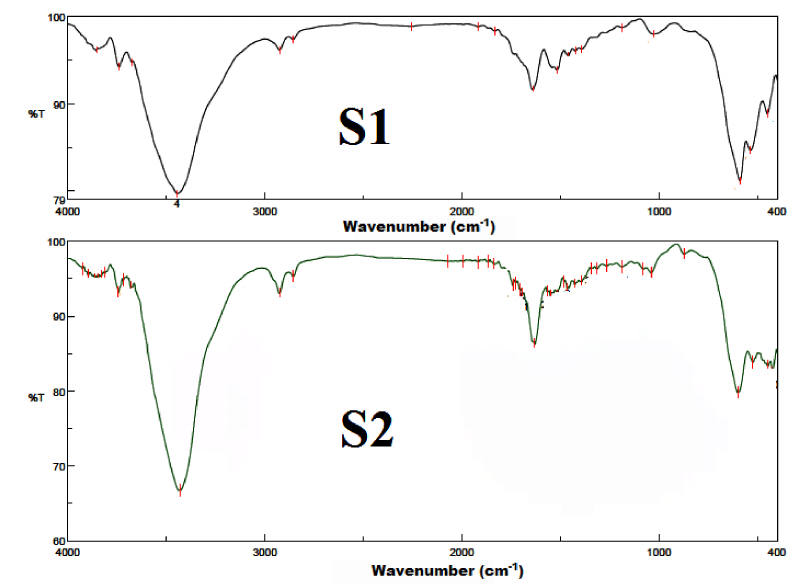
Figure 3. FT-IR patterns of the S1 and S2